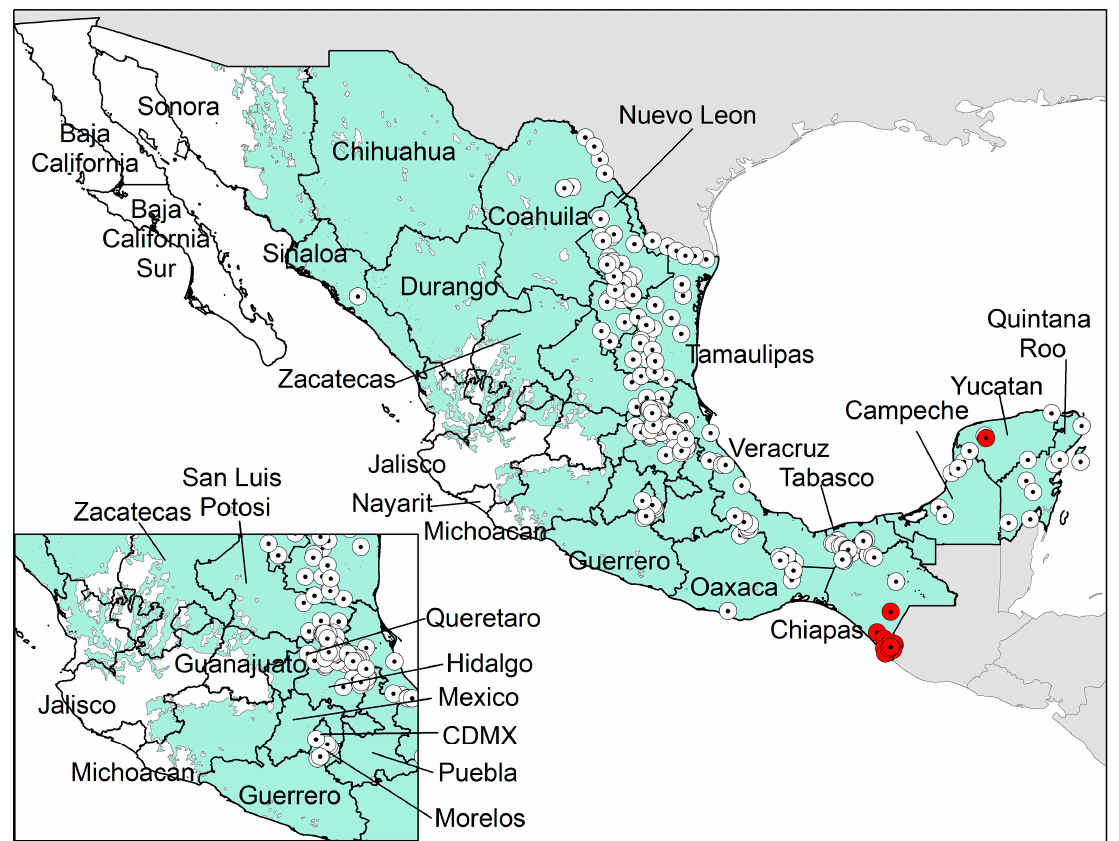
Figure 1. A map of México showing the boundaries of the Mexican states. The white dotted circles represent the occurrence records of Aedes albopictus available for the model calibration. The red dotted circles represent the occurrence records of natural Wolbachia infections in Ae. albopictus populations. The green background depicts the accessible areas where the Ae. albopictus model was calibrated. The square in the bottom left corner of the map presents a close-up of the central states of México .